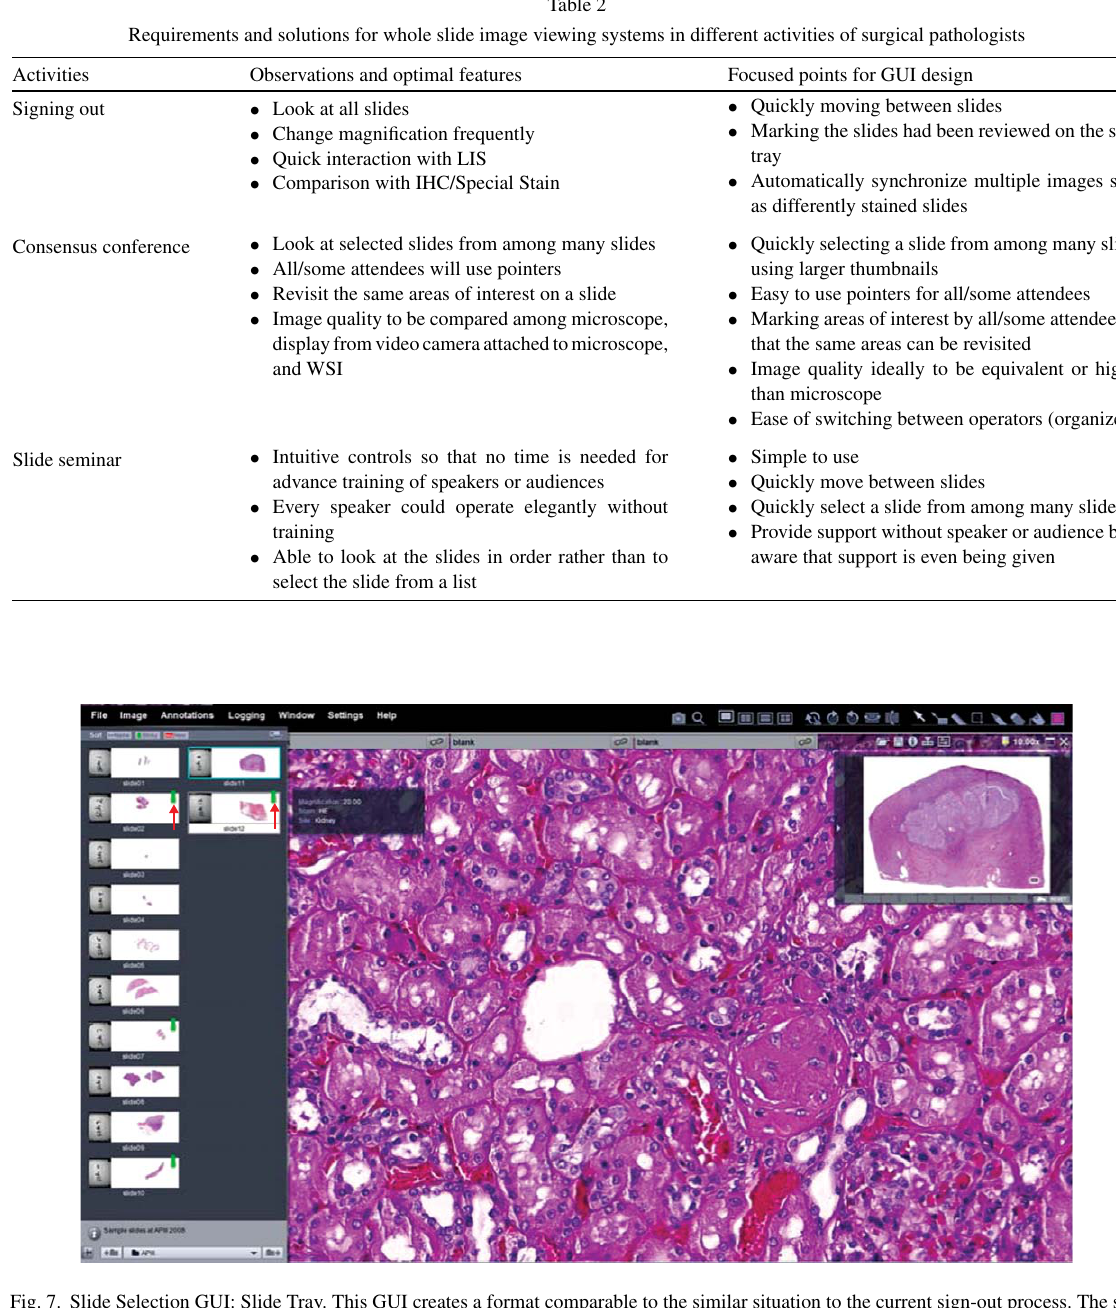
Fig. 7. Slide Selection GUI: Slide Tray. This GUI creates a format comparable to the similar situation to the current sign-out process. The size of the slides on the left side is very close to the size of an actual glass slide when using a 24–26inch display monitor. Pathologist can check which slides he or she has already observed through an electronic post-it note